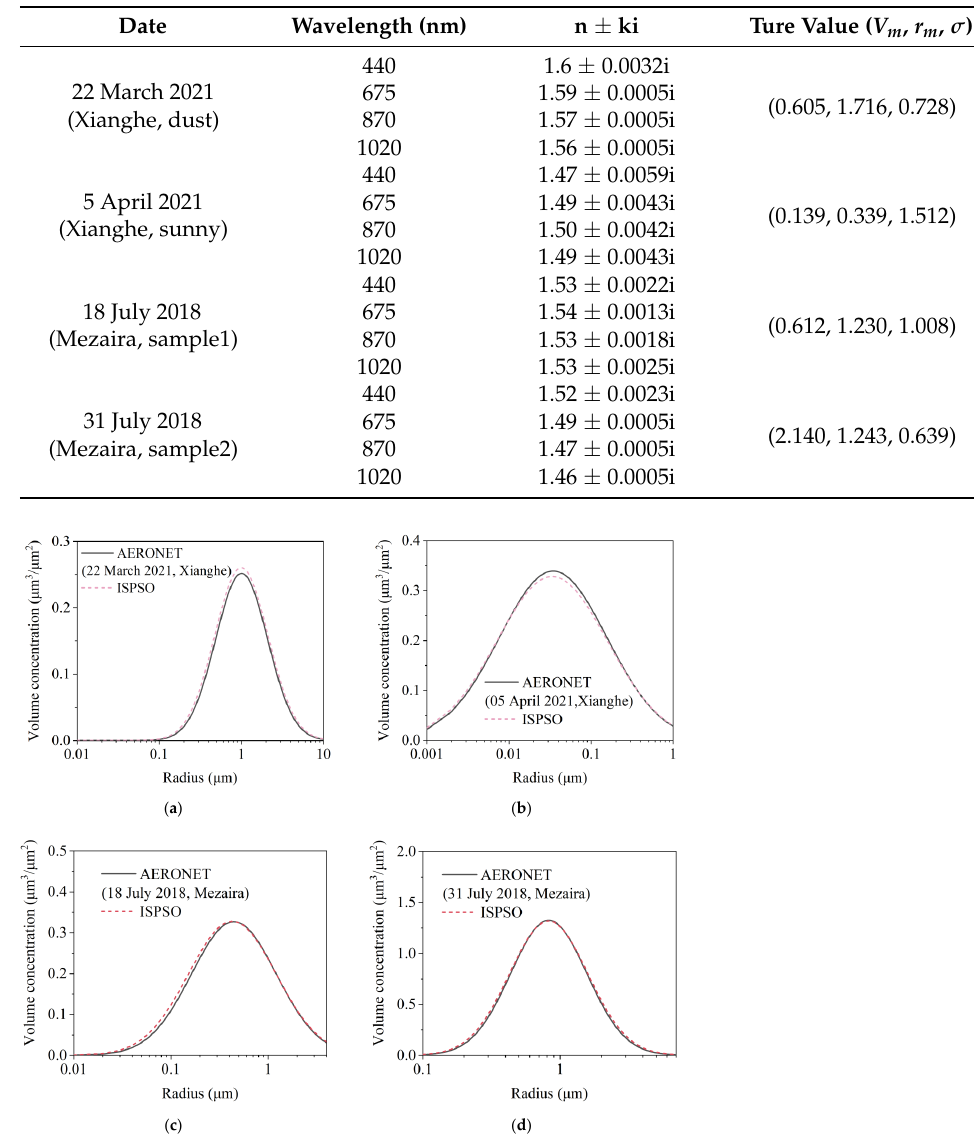
Table 9. The complex refractive index and PSD measured by AERONET.